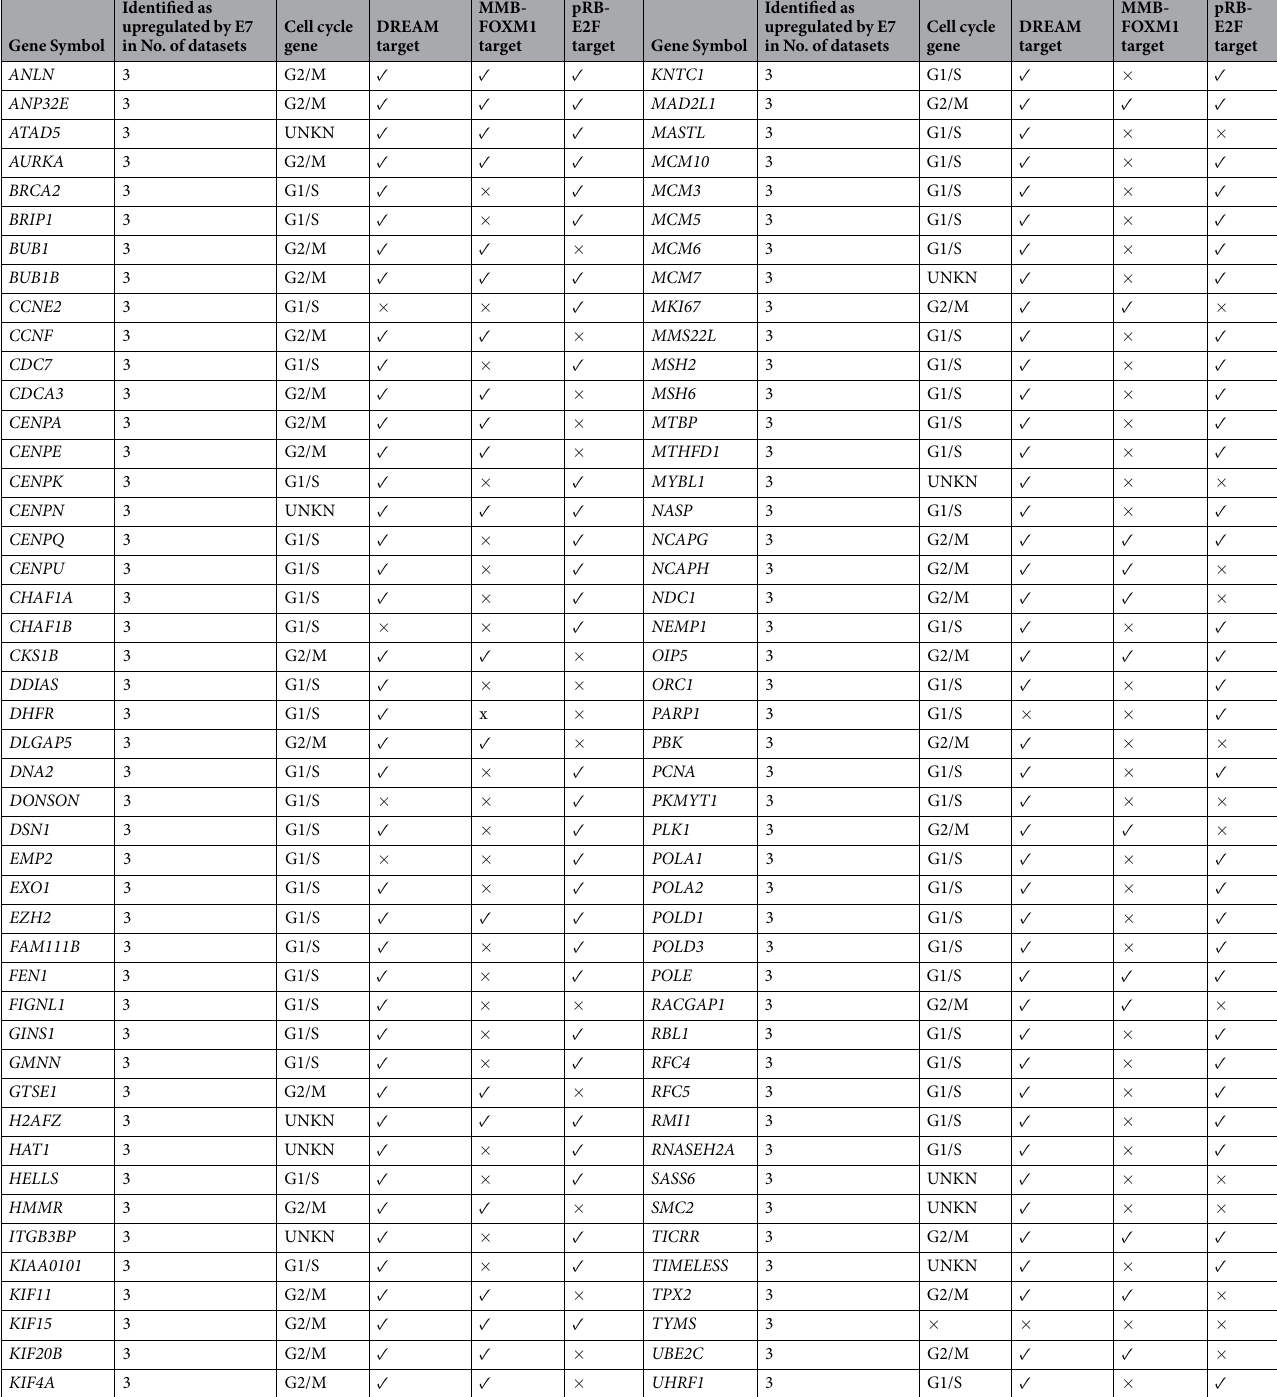
Table 3. Genes upregulated after HPV E7 expression with an identification-overlap of three in six datasets. 92 genes were identified in 3 of the 6 datasets as being deregulated by HPV E7 (extracted from Table S1). Information whether the gene is a cell cycle gene, including the phase of peak expression, and whether it is a DREAM, MMB- FOXM1 or pRB-E2F target were extracted from Fischer et al . 23 . UNKN, timing of peak expression of the cell cycle gene is unknown; X, cell cycle-dependent expression was not reported in the